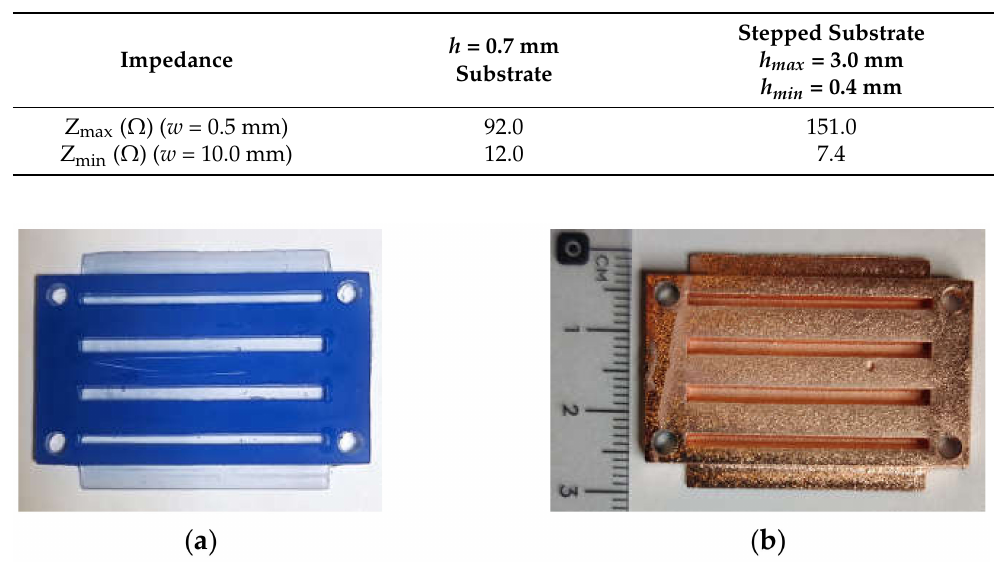
Figure 13. Fabricated low pass filter prototype: ( a ) before the deposition of copper metallic paint and electroplating process on the ground plane; ( b ) after the metallization